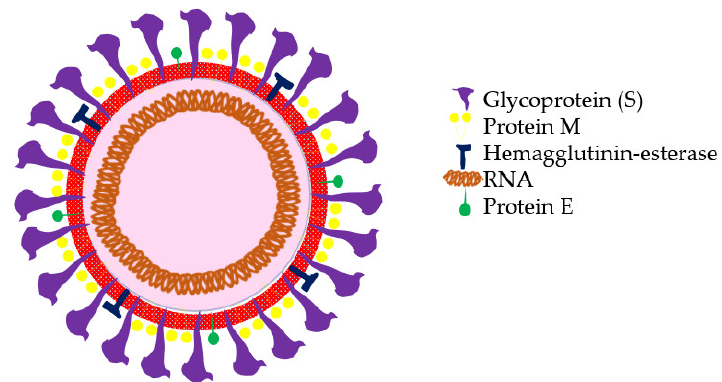
Figure 1. Molecular structure of severe acute respiratory syndrome coronavirus 2 (SARS-CoV-2).